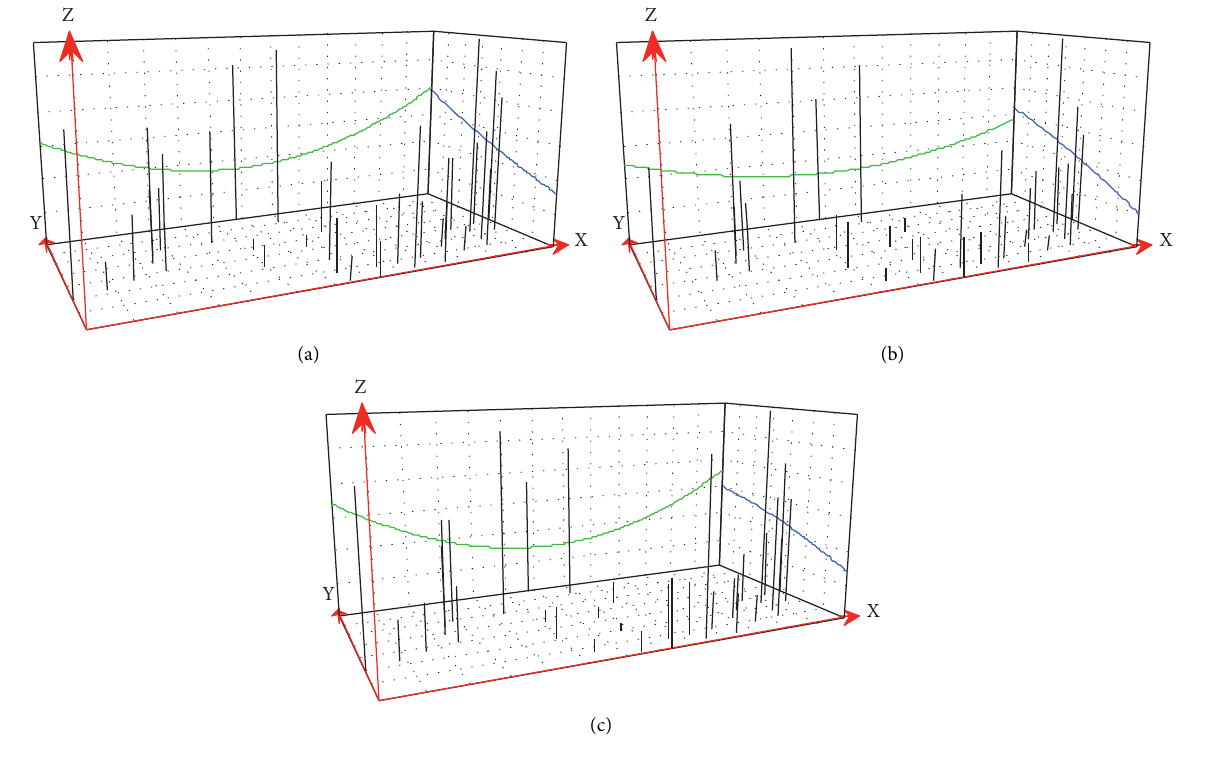
Figure 6: The spatial trend of the UGDI. (a) 2008. (b) 2013. (c) 2018. Table 5: Selection of influencing factors for green development.